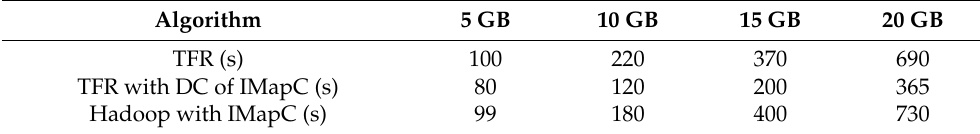
Table 7. Performance Comparison of TFR, TFR with DC of IMapC, and Hadoop on running Sort program.